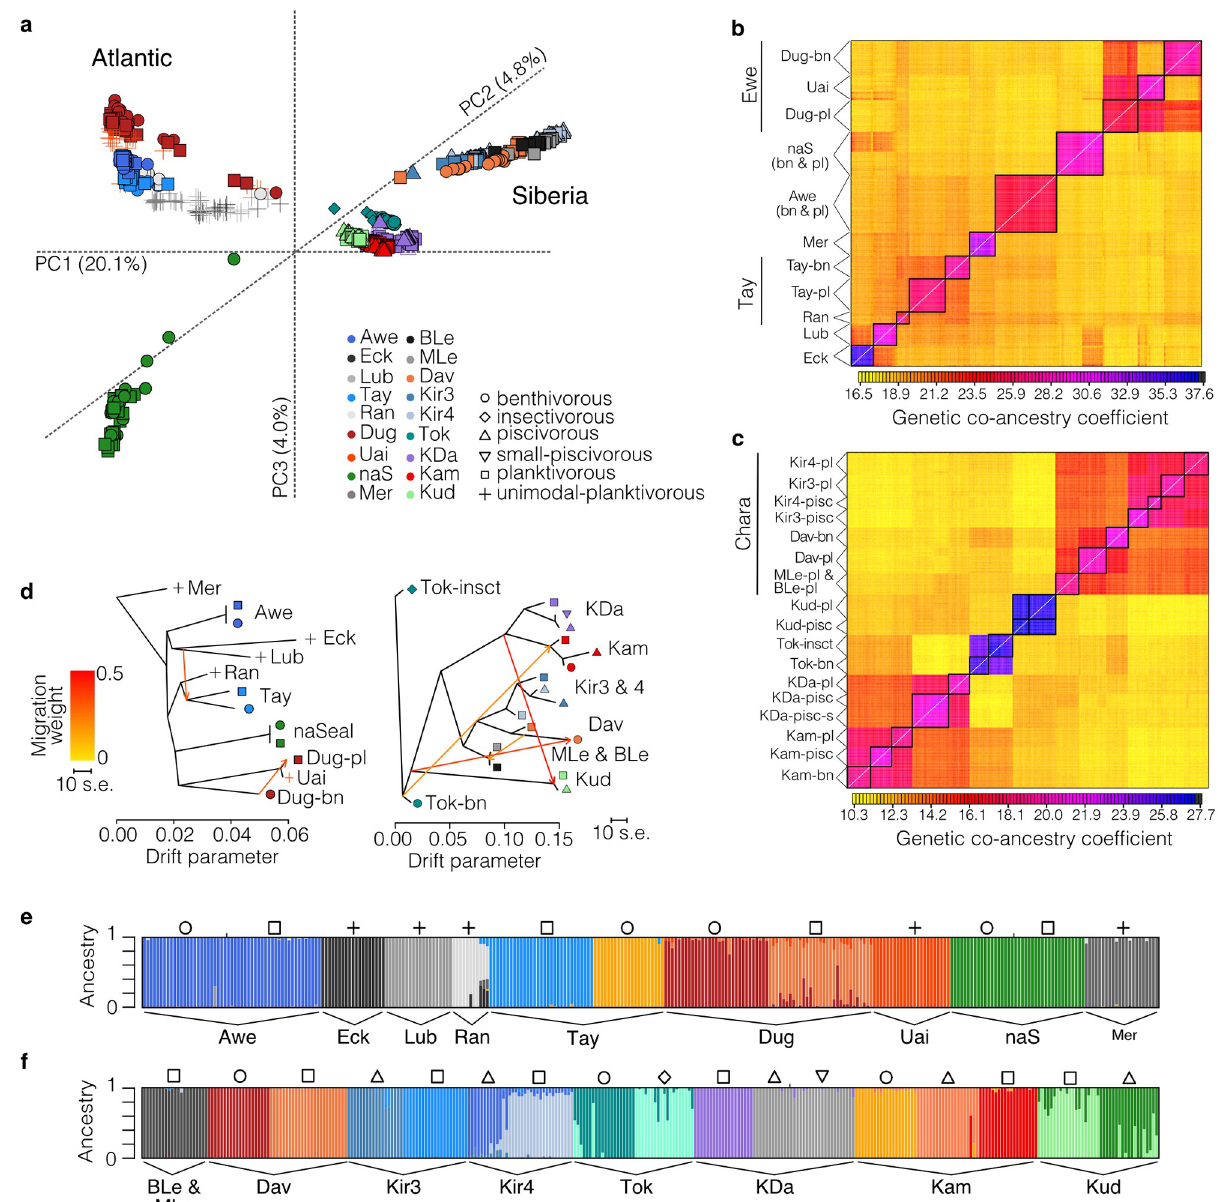
Fig 3. Hierarchical population genetic structure and genomic background divergence. ( A ) 3-dimensional principal components plot for all individuals (N = 630) based on 12,215 SNPs. Lake abbreviations are explained in S1 Table. PC1 mostly separates the Atlantic and Siberian lineage, PC2 mostly separates catchments within the Siberian lineage and PC3 separates na Sealga from all other populations within the Atlantic lineage ( B,C ) fineRADstructure results showing co-ancestry coefficients between individuals from the ( B ) Atlantic and ( C ) Siberian lineage. Ecotypes or lake populations that form discrete genetic clusters are enclosed in black boxes. Note the high genetic co-ancestry across lakes within the same catchment, such as ( B ) Dughaill (Dug) and Uaine (Uai) in the Ewe catchment or ( C ) Kiryalta-3 (Kir3), Kiryalta-4 (Kir4), Davatchan (Dav), and Maloe and Bol’shoe Leprindo (MLe, BLe) in the Chara catchment. Ecotype descriptions (abbreviations in S1 Table) are shown unless populations were unimodal or ecotype-associations unknown. Populations are ordered in the same way along the x-axis of the co-ancestry matrices. ( D ) Allele frequency-based maximum-likelihood trees showing the most likely phylogenetic relationships across lakes and ecotype pairs by lineage, including two and four fitted migration events in the Atlantic and Siberian lineage, respectively. Migration events are shown as arrows coloured by migration weight. ( E,F ) Admixture plots showing the genetic ancestry for all individuals from the ( E ) Atlantic and ( F ) Siberian lineage for K = 11 and K = 16, respectively. Ecotypes are marked by symbols above each cluster.